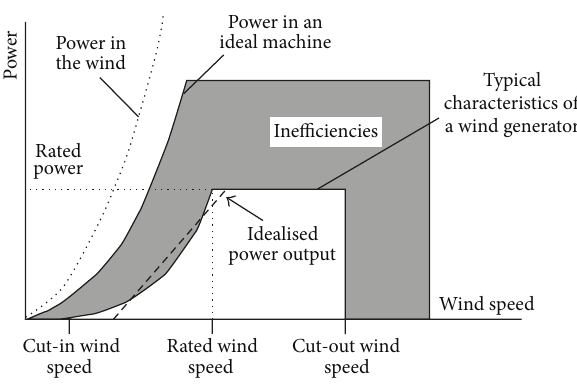
Figure 2: A wind turbine characteristic